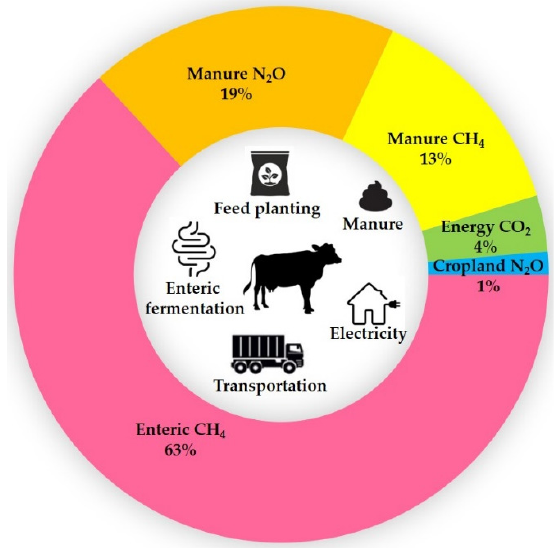
Figure 2. GHG emissions during beef production in Saskatchewan, Canada [32].